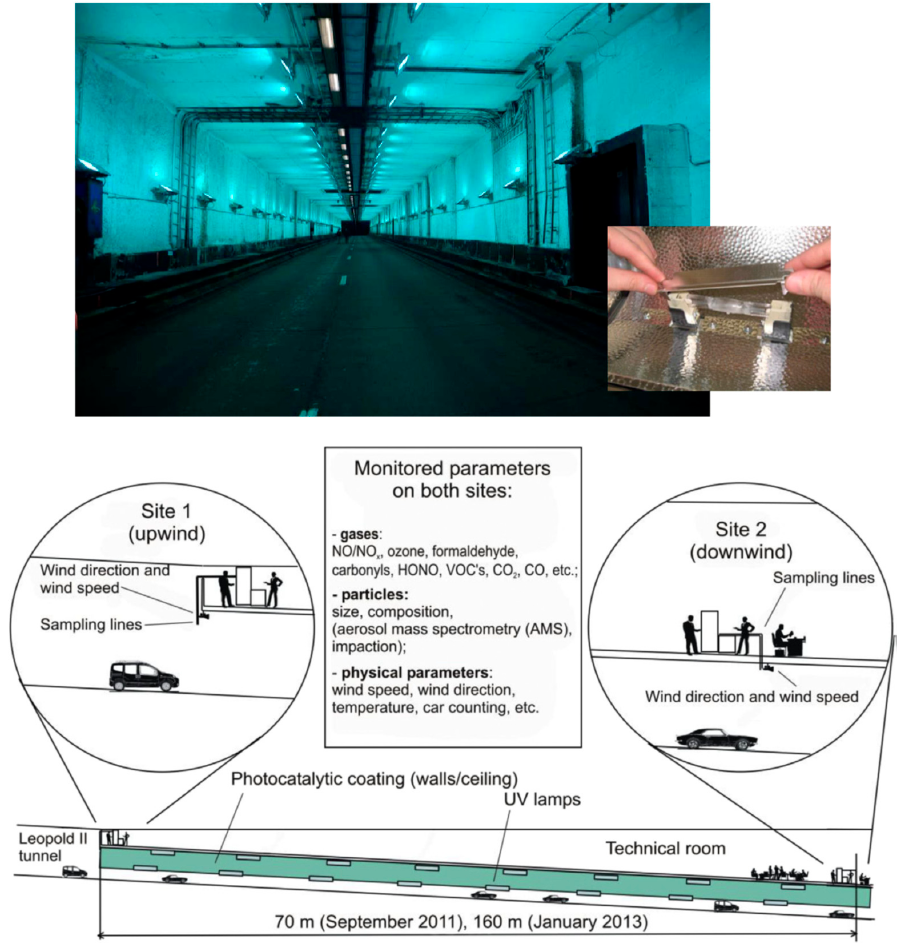
Figure 53. ( upper ) Condition of the Leopold II tunnel after coating the walls and also showing the lighting system; and ( lower ) schematic representation of the test sites in the Leopold II tunnel during the PhotoPAQ field trials. Reproduced with permission from Boonen et al. [158]. Copyright 2015